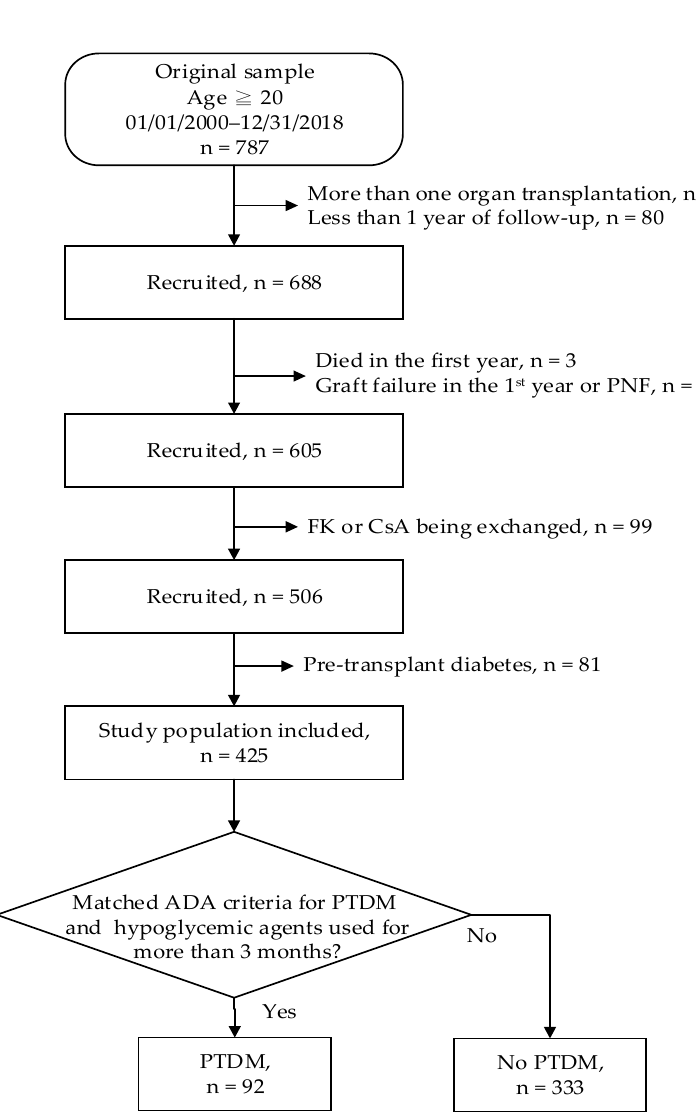
Figure 1. Flowchart of patient inclusion process. ADA: American Diabetes Association; CsA: cyclosporine; FK: tacrolimus; PNF: primary non-function; PTDM: post-transplant diabetes